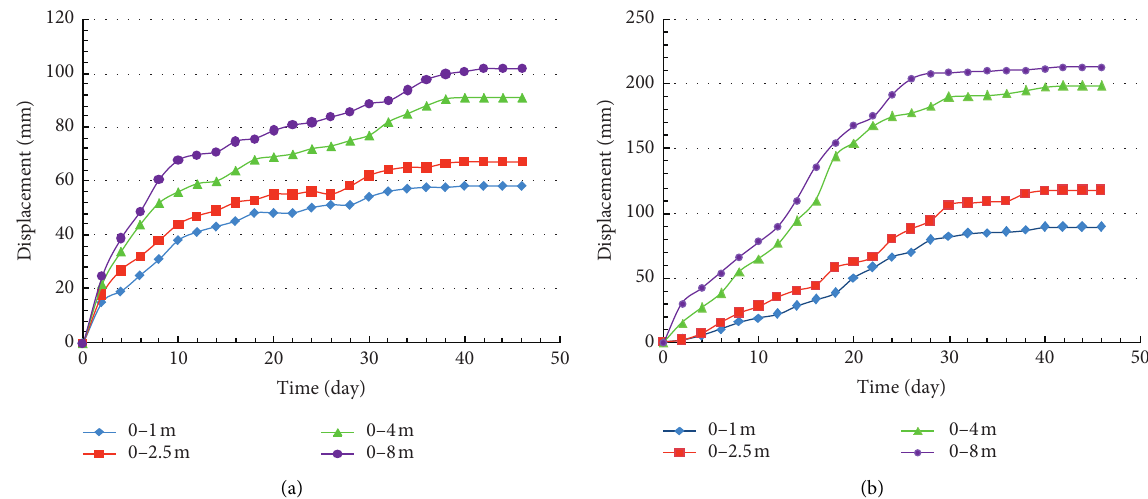
Figure 19: Displacement curves of roof with risks of caving of grades II and III in the intake airway in working face 11030: (a) grade II; (b) grade